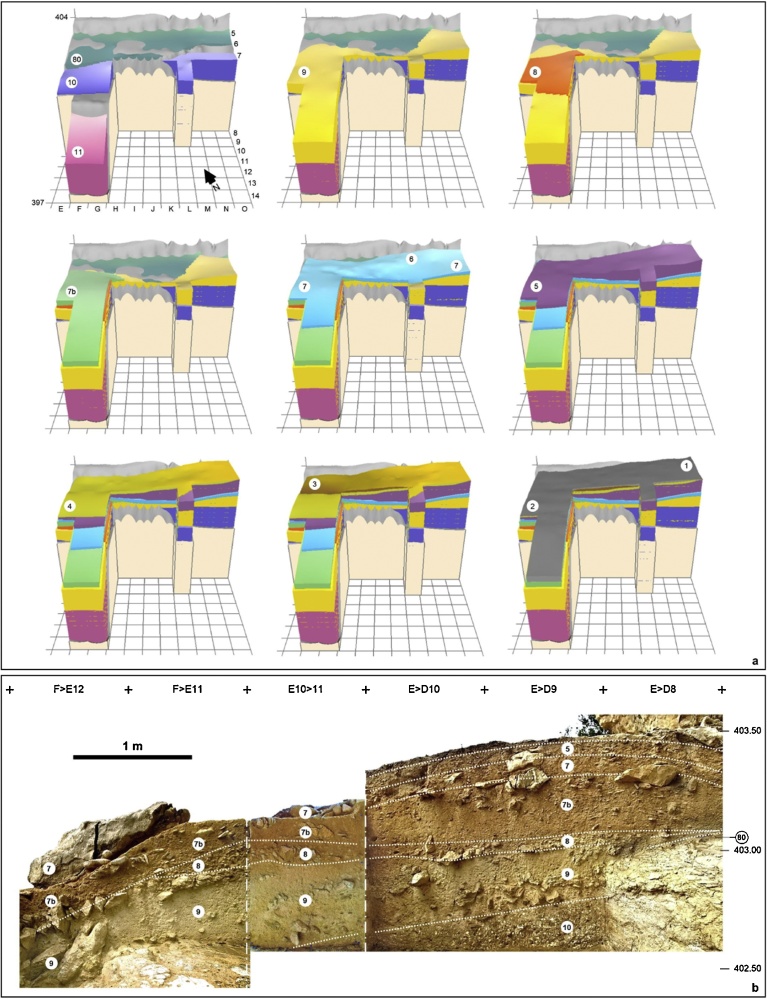
Finca Doña Martina. a. 3D model of the accumulation (for an extended discussion, see the SI appendix); the labels denote the different stratigraphic units recognized. b. The stratigraphic succession in the trench’s western wall. Elevations are in m asl.